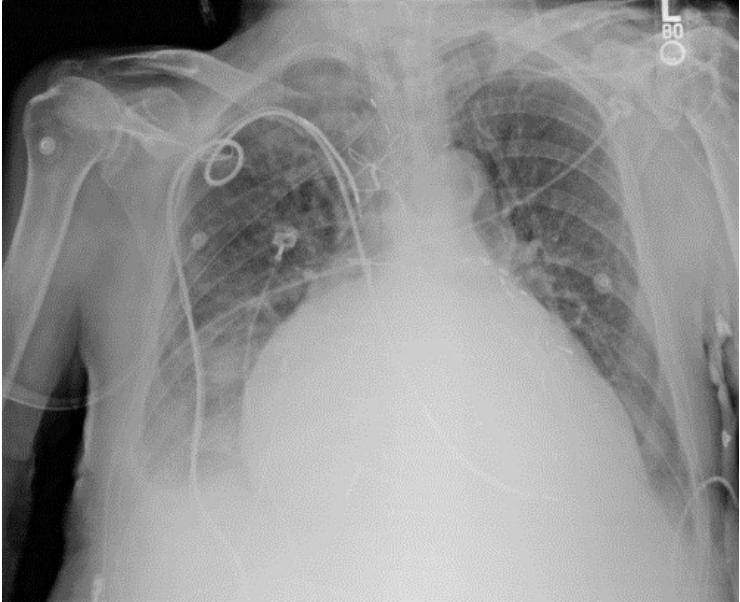
Figure 3. An image from portable chest radiograph (CXRs) database.